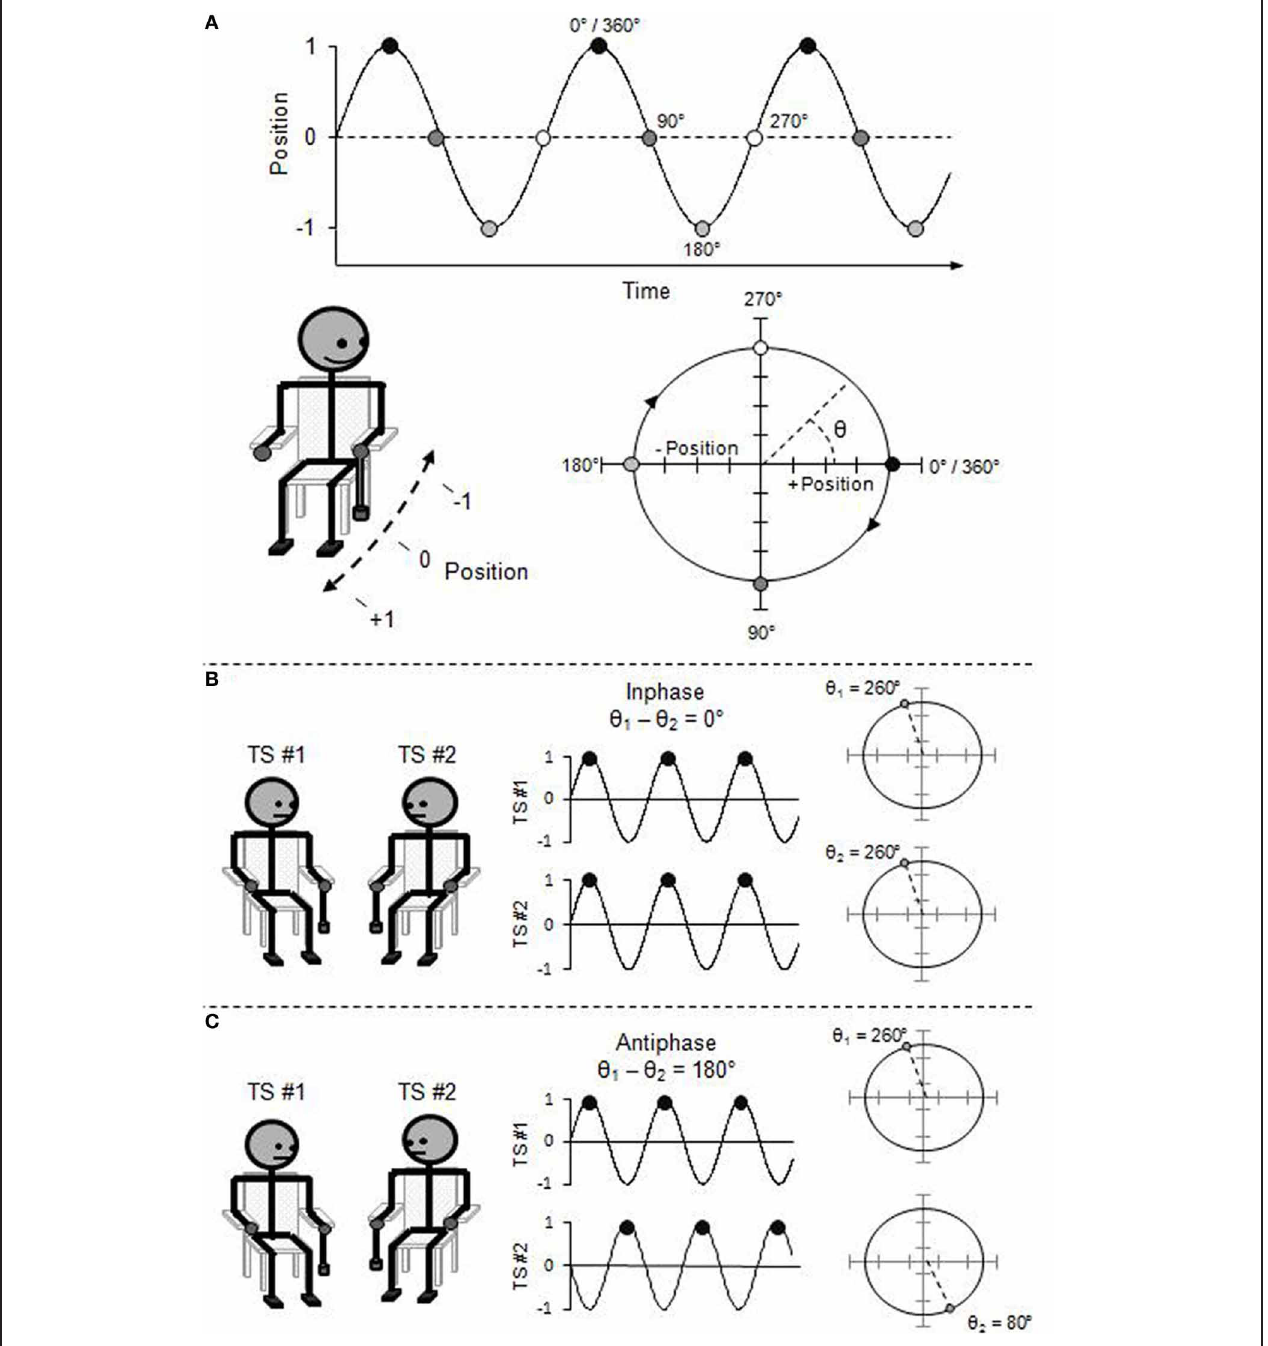
FIGURE 1 | (A) Rhythmic pendulum swinging expressed in phase angle and represented as a position time-series and a position-by-velocity phase space. (B) Inphase interpersonal coordination expressed in